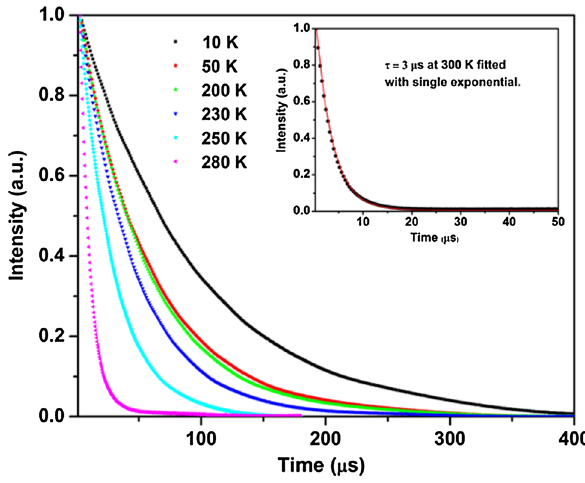
Fig. 5 Luminescence decay curves of a NWO crystal at different tem- peratures; inset shows a single exponential fit to the data at room tem-